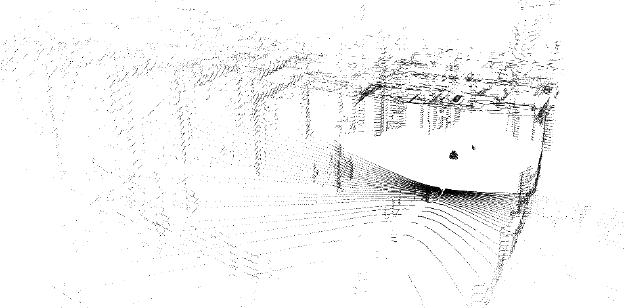
Figure 2. A 360 ◦ point cloud acquired by the Velodyne HDL-32e LiDAR scanner, associated with the stitched lady bug image of Figure 3, captured at the Dow chemical